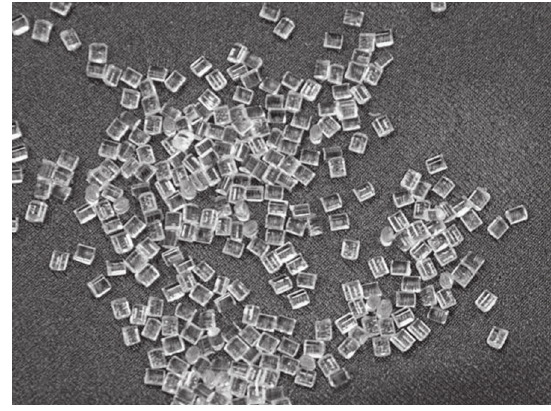
Figure 1. Experimental material